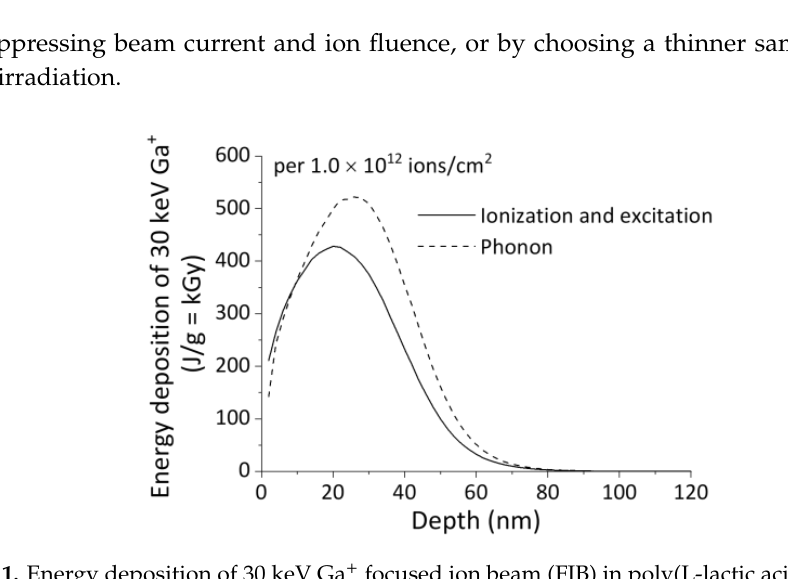
Figure 1. Energy deposition of 30 keV Ga + focused ion beam (FIB) in poly(L-lactic acid) (PLLA) per 1.0 × 10 12 ions / cm 2 .